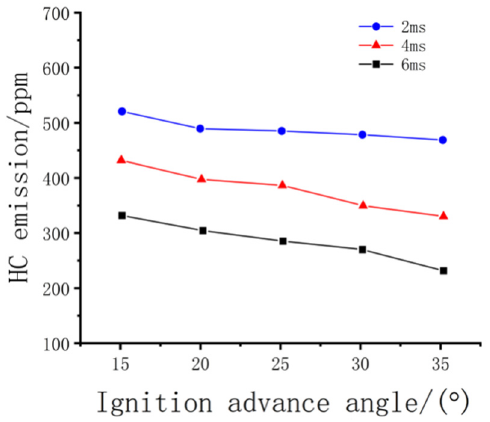
Figure 28. Effect of the ignition parameters on HC emissions.